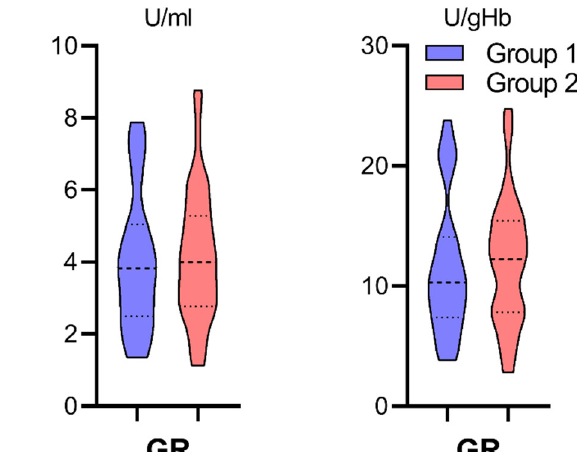
Figure 5. Violin plots of distribution (Mann-Whitney U test, N = 66, n 1 = 26, n 2 = 40): GST activity per volume ( p = 0.6250), GST activity per hemoglobin mass ( p = 0.2639), GSH concentration ( p = 0.5357).